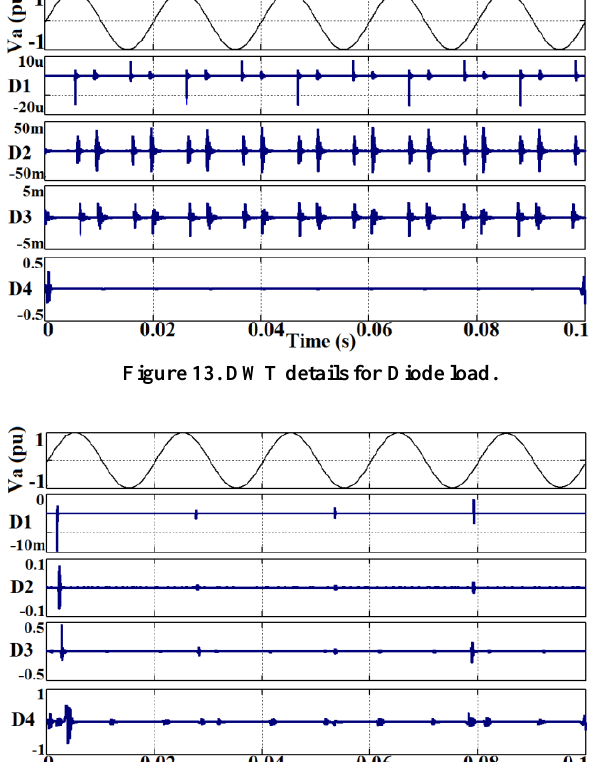
Figure 11. DWT details for electric Arc furnace.